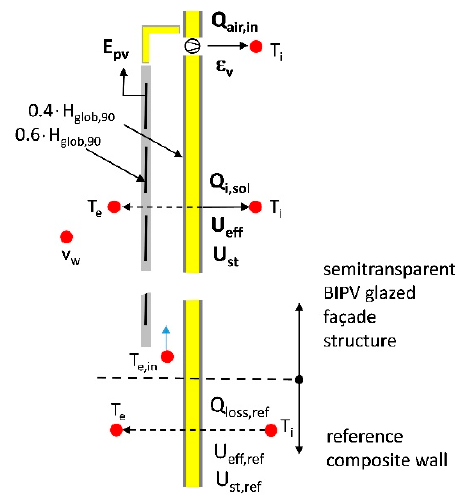
Figure 4. Scheme of indicators of the efficiency of solar energy utilization with the pilot semitransparent BIPV glazed façade structure; diurnal electricity production E PV ; diurnal heat supplied with preheated air for space ventilation Q a,in ; and heat gains through the opaque façade wall Q i,sol were the basis for developing approximation models of energy efficiency, while others, such as static U st , dynamic thermal transmittance U eff , and preheating efficiency ε v , are used to emphases the advantage of the pilot semitransparent BIPV glazed façade structure.